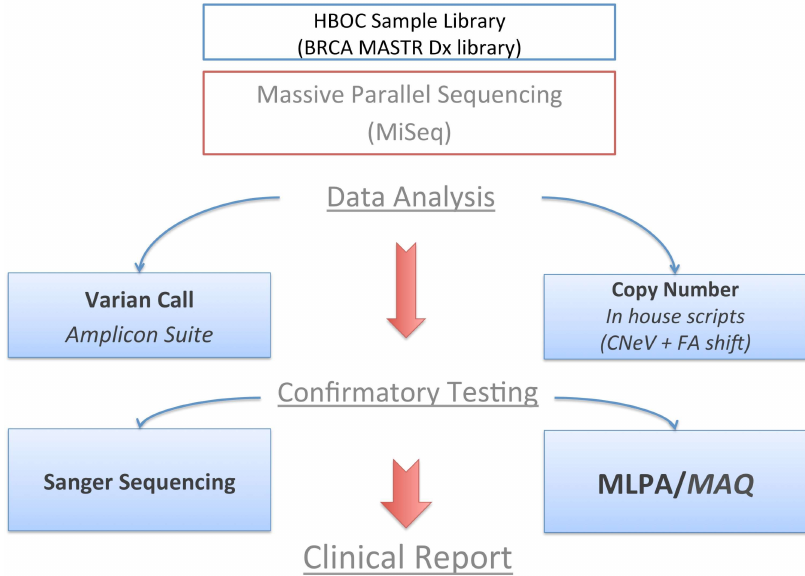
Figure 4. The Standard Operative Procedure (SOP) reflecting the diagnostics workflow used for the identification of the germline BRCA2 deletion is